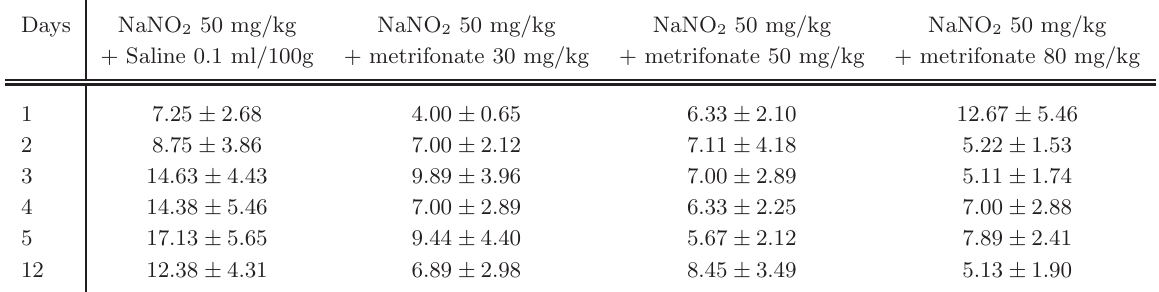
Table 4 Effects of metrifonate on active avoidance test (shuttle box) in a model of hypoxia: number of intertrial